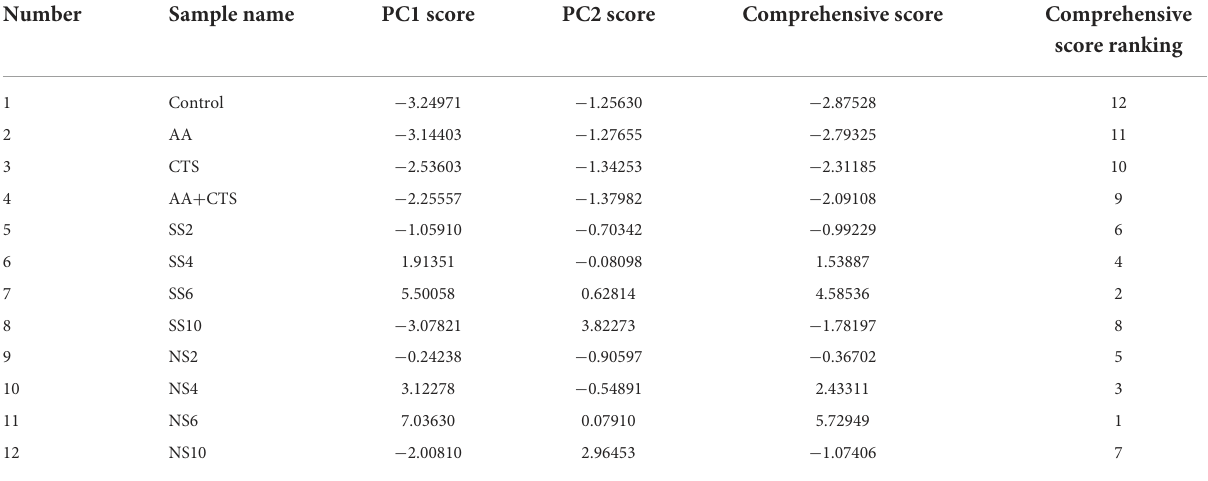
TABLE 8 Main component score and comprehensive score of soy